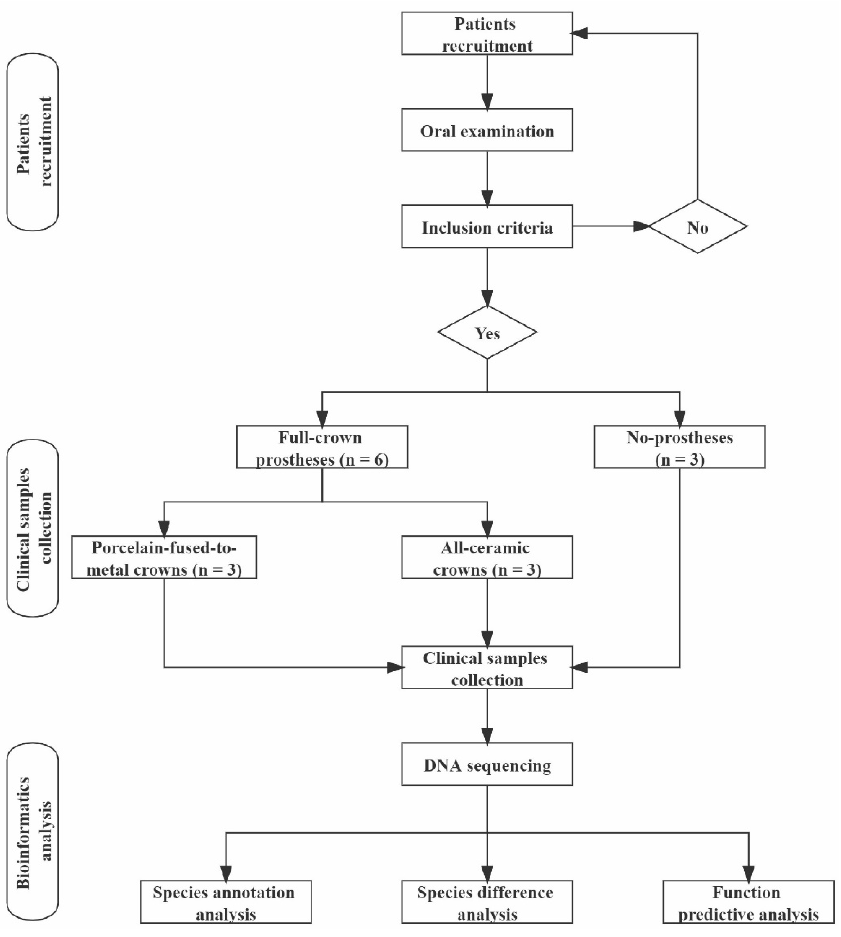
Figure 1. Experimental flow chart.